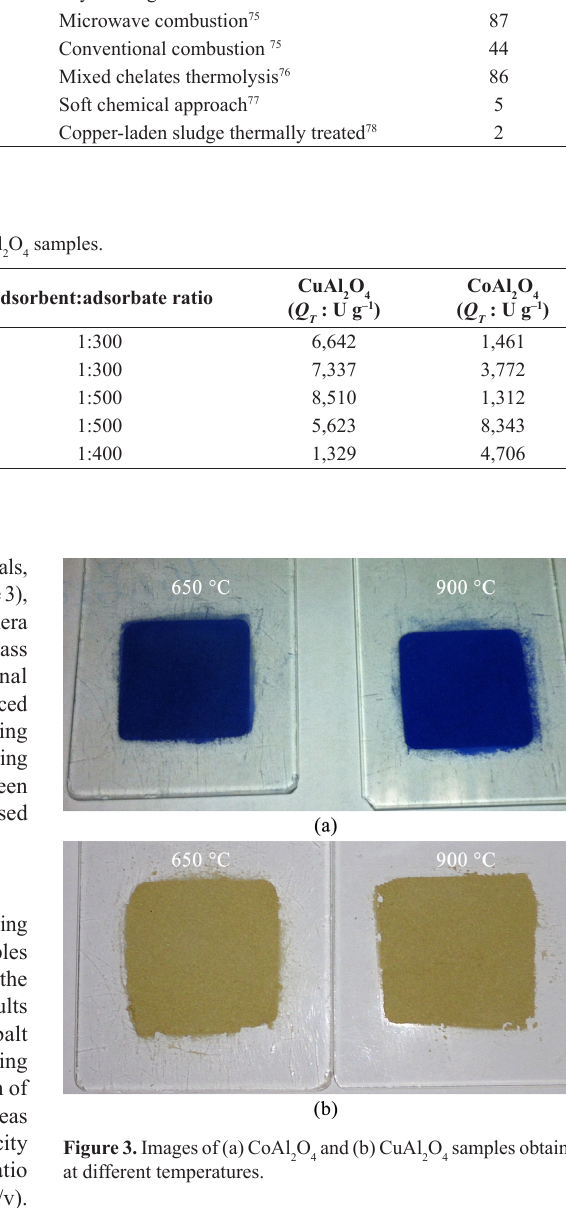
O samples obtained 2 4